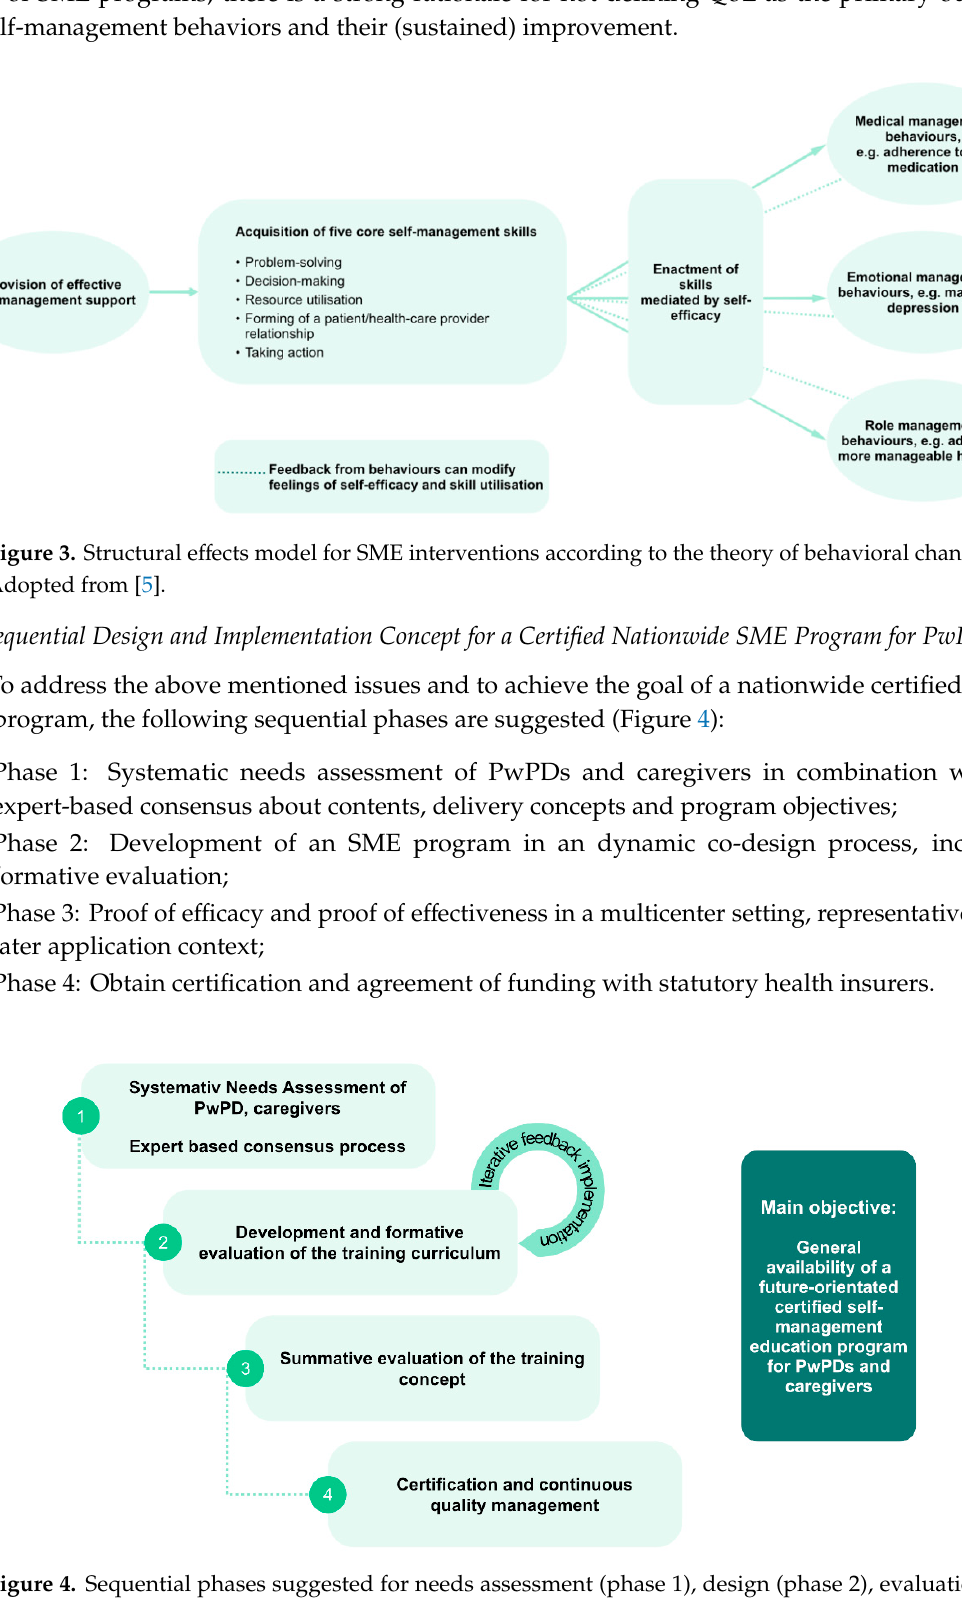
Figure 4. Sequential phases suggested for needs assessment (phase 1), design (phase 2), evaluation for effectiveness (phase 3), and for certification and nationwide implementation of a structured SME program for PwPDs (phase